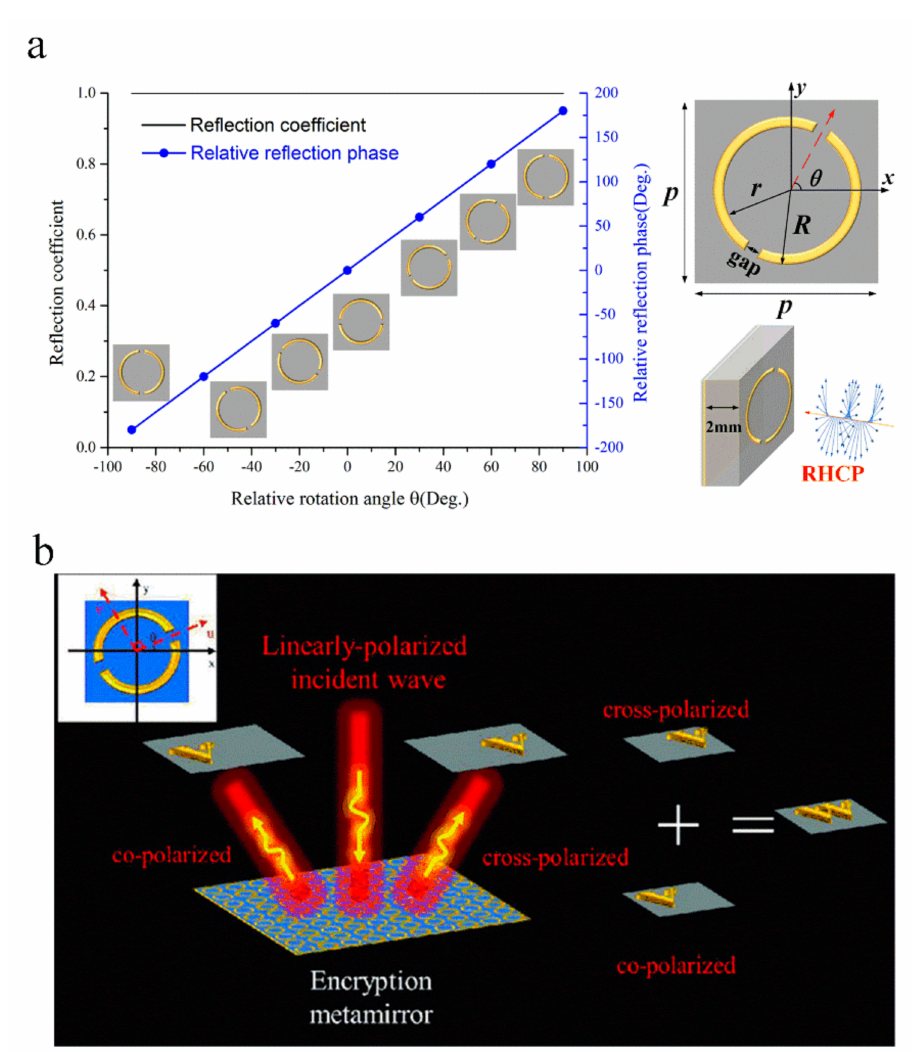
Figure 4. ( a ) Numerical characterization results of reflection − type PB phase elements. Reprinted with permission from ref. [100]. Copyright 2019 Optical Society of America. ( b ) Schematic representation of the proposed geometric phase metasurface-based dual-polarized tri-channel encrypted holography. Reprinted with permission from ref. [101]. Copyright 2020 John Wiley and